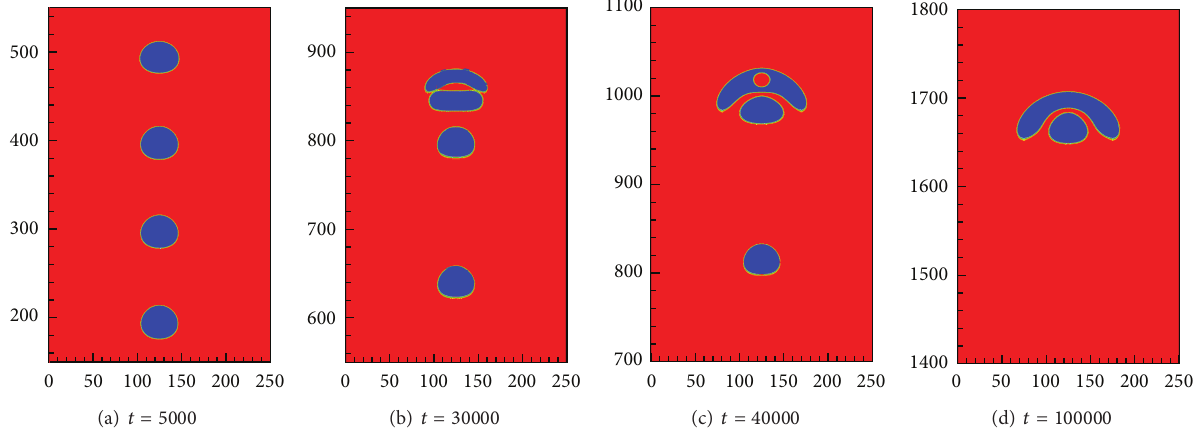
Figure 9: The contour of order parameter of four bubbles for Eo = 5 .